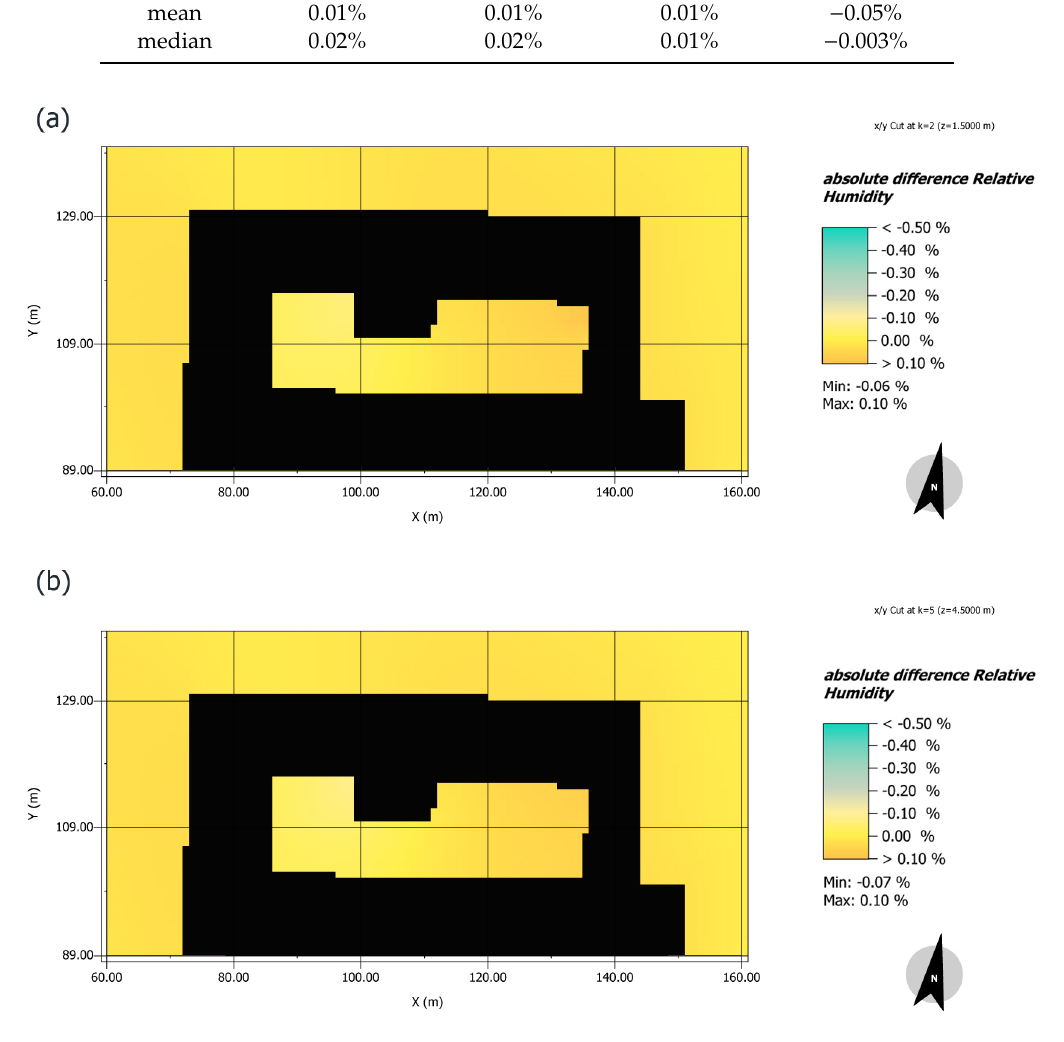
Figure 17. The comparison of initial state with reference green roof relative humidity in horizontal cross sections at the height of 1.5 m ( a ) and 4.5 m ( b ). Figure by authors.